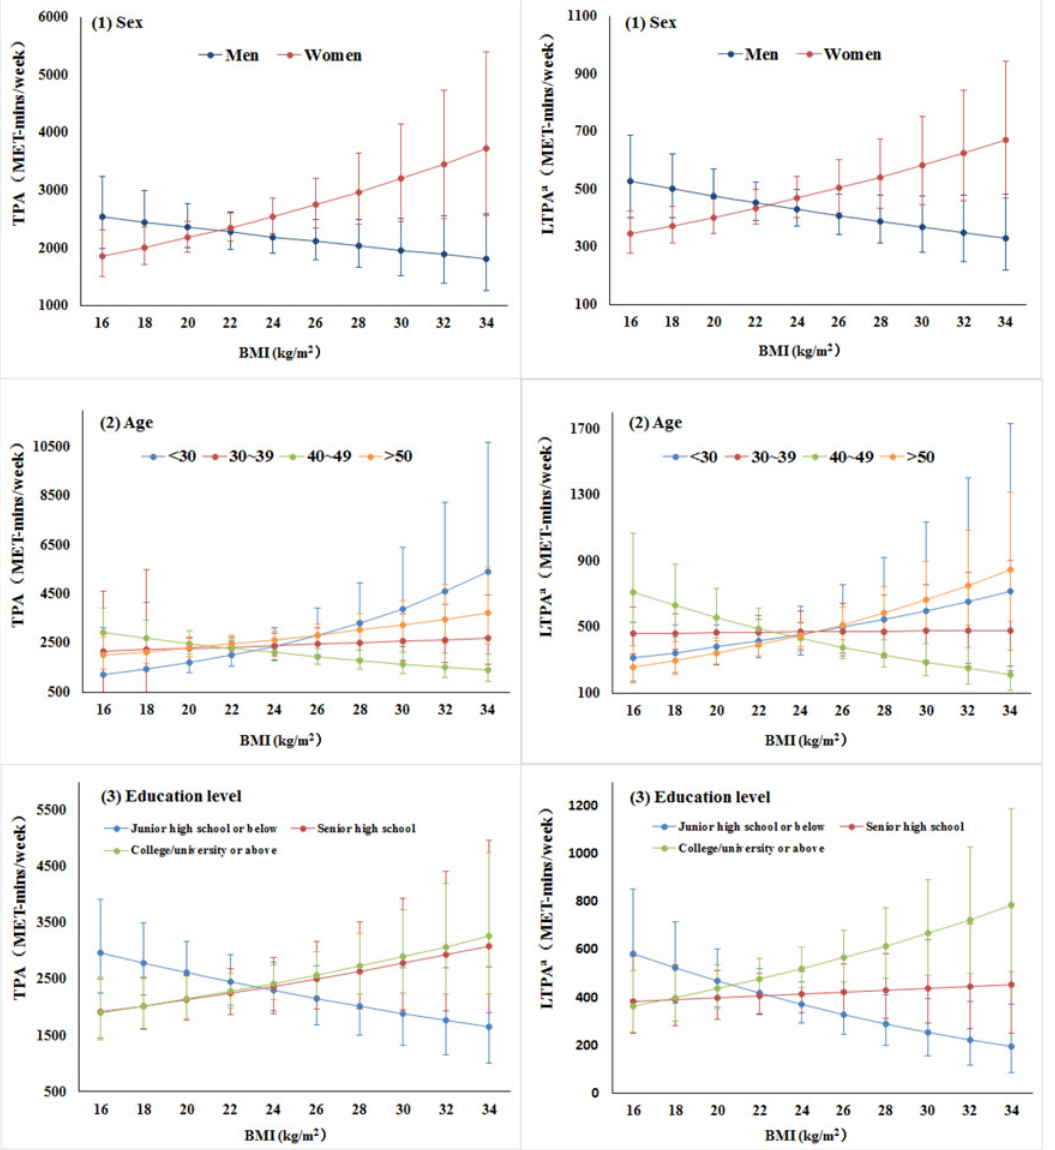
Fig 1. Associations between BMI and TPA/LTPA across sex, age, and education level groups; after grouping by community . TPA and LTPA in this figure were calculated as e M -100 and e N -100 separately, where M and N is the adjusted mean calculated using a multilevel mixed-effects model.